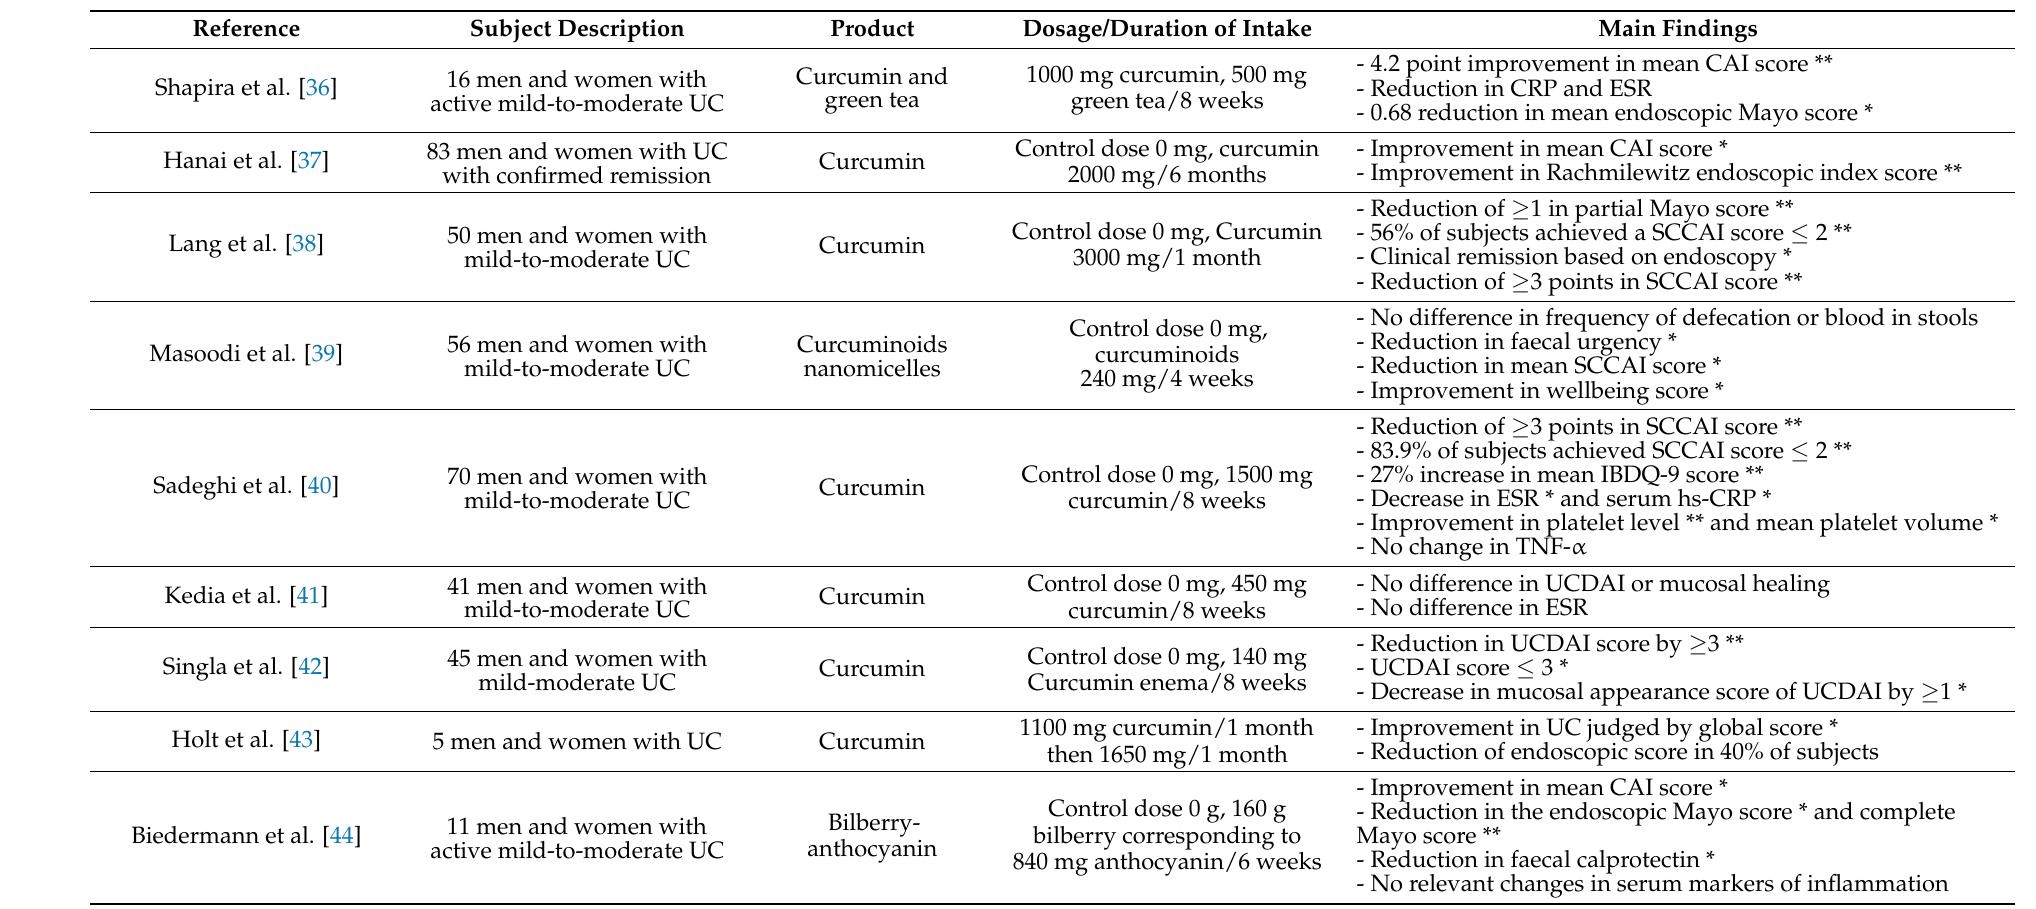
Table 1. Summary of human intervention studies of (poly)phenols in ulcerative colitis